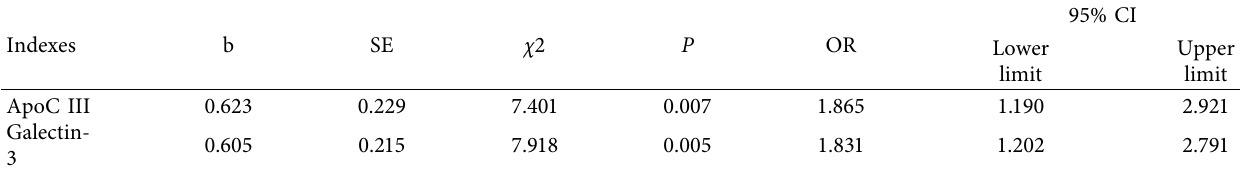
Table 2: Combined model of ApoC III and galectin-3 for predicting pregnancy outcome in patients with GDM.